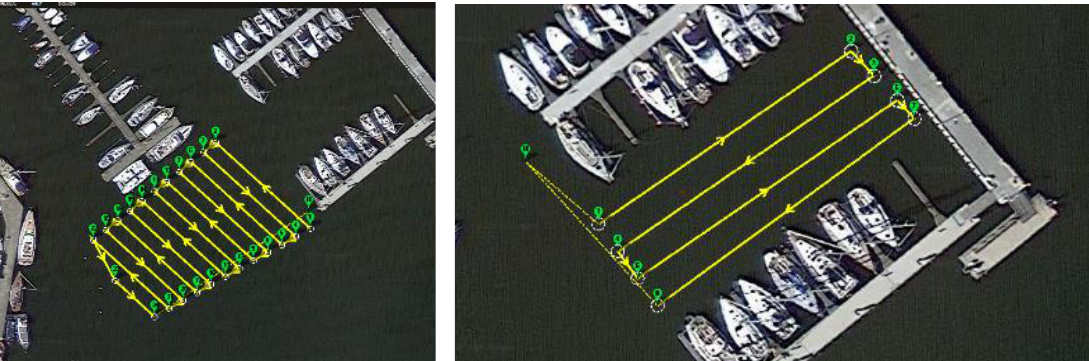
Figure 2. Sounding profile plan for USV operating in the automatic mode.